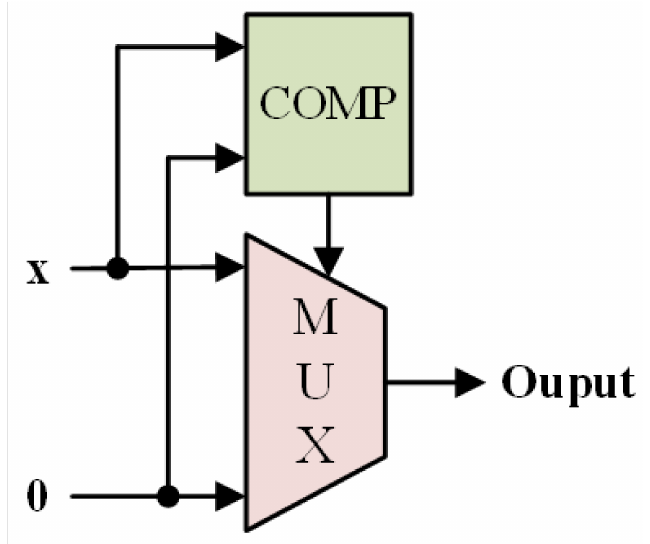
Figure 4. Block diagram of ReLU.